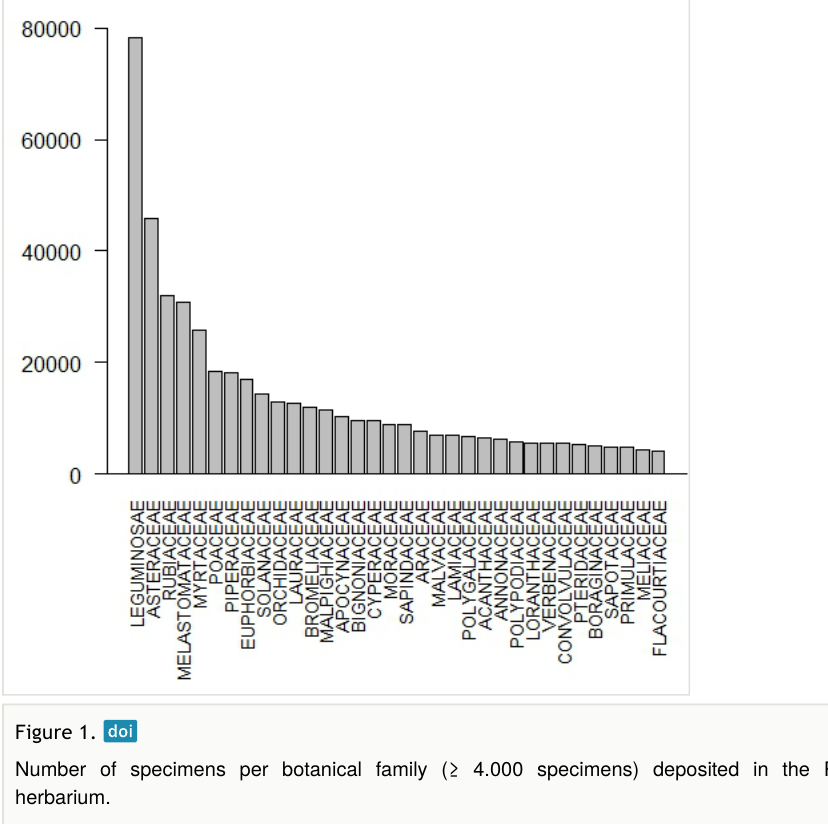
Number of specimens per botanical family ( ≥ 4.000 specimens) deposited in the RB